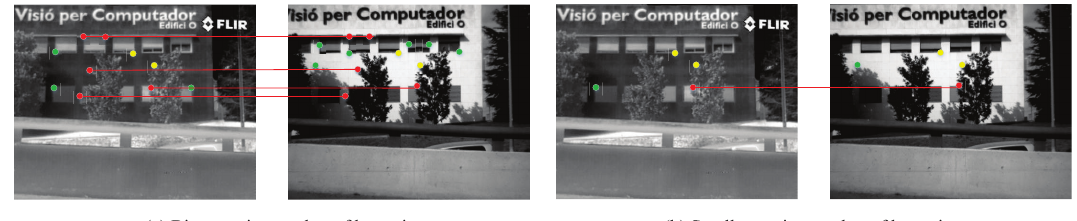
Figure 10. Illustration of the accuracy rate (AR) for the keypoints.